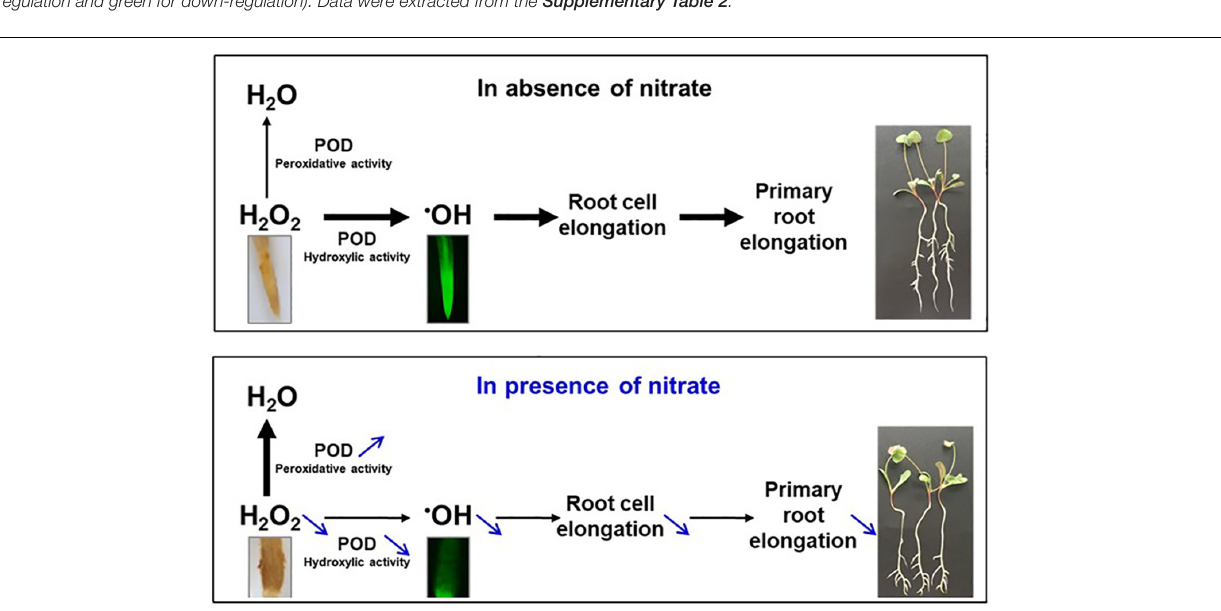
Frontiers in Plant Science |